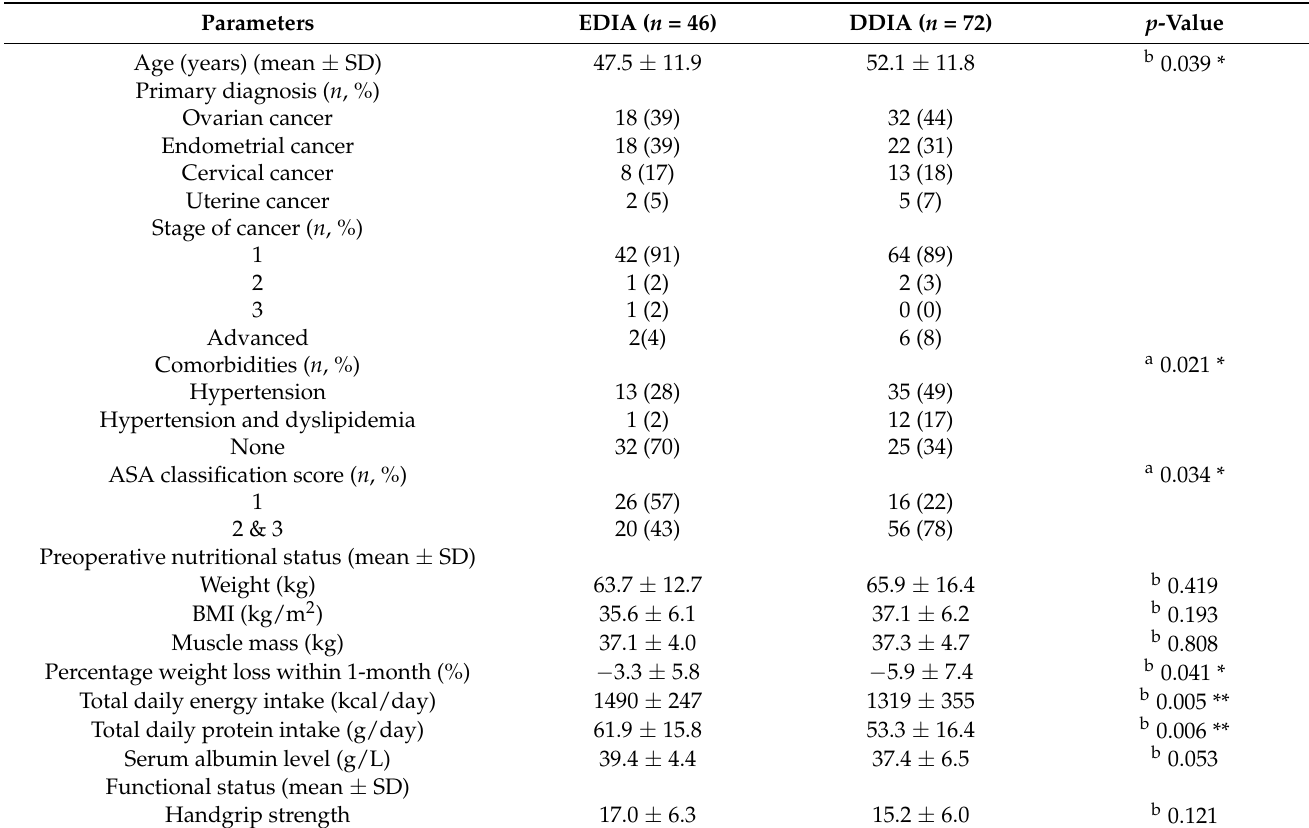
Table 1. Clinical characteristics, nutritional status and function status in Gynecologic Cancer patients ( N =